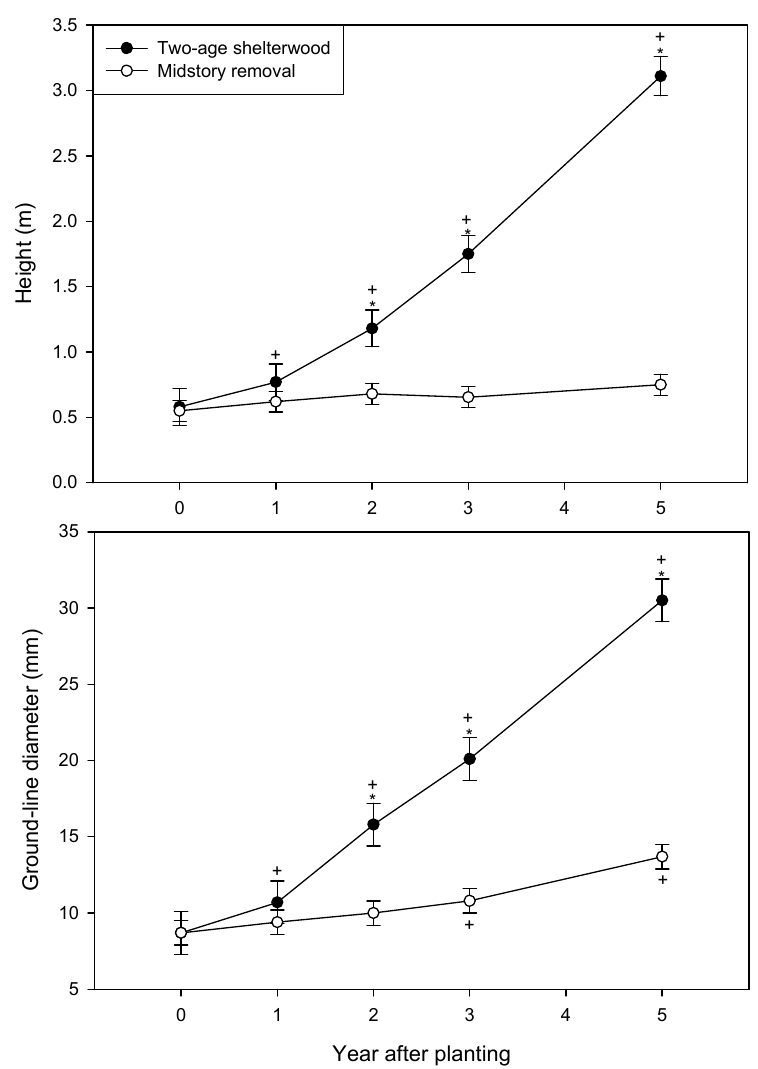
Figure 1. Height and ground-line diameter with associated standard error bars for five years after planting American chestnuts in two silvicultural treatments. Asterisks, positioned above the two-age shelterwood line, indicate significant differences between the two treatments within a year. Plus signs, positioned above the two-age shelterwood line or below the midstory-removal line, indicate significant differences between that year and the year prior within silvicultural